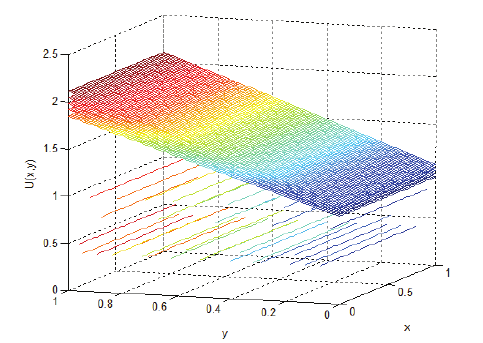
Fig. 3. Some α − cuts of fuzzy PHFDEs (26)-(28). The dark curve in the center of the surface corresponds to the deter- ministic solution [ U ( x , y )] 1